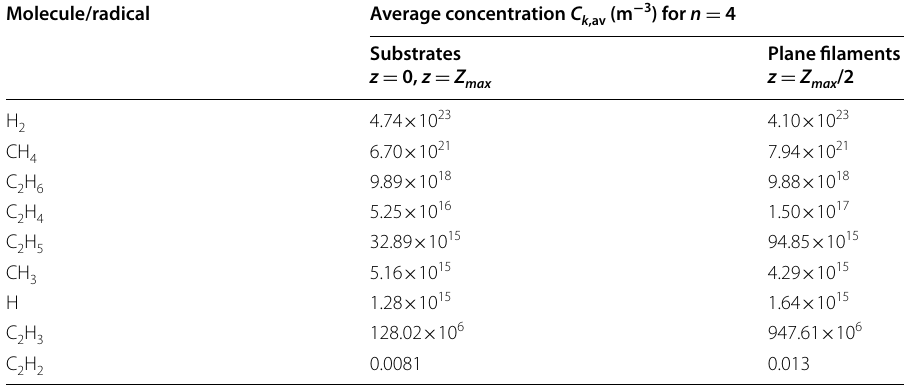
Table 3 Average concentrations of species at the substrates and at the plane of the filaments Molecule/radical Average concentration C k ,av (m − 3 ) for n